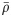
Importance of cluster translation moves.(a) ρ¯ and (b) ϕc curves for the An+Bn (purple) and An-Bn systems (green) at T* = 0.383. The solid lines are identical with the curves in panels (c) and (d) of Fig 7. The dotted lines show the simulation results under the same system conditions but the frequency for cluster translation moves is set to zero. Not only do the systems phase separate and percolate at higher saturation concentrations, but also we can see that both percolation and separation are suppressed highly. Furthermore, errors are generally higher, due to the systems being highly dependent on the initial conditions of the system.